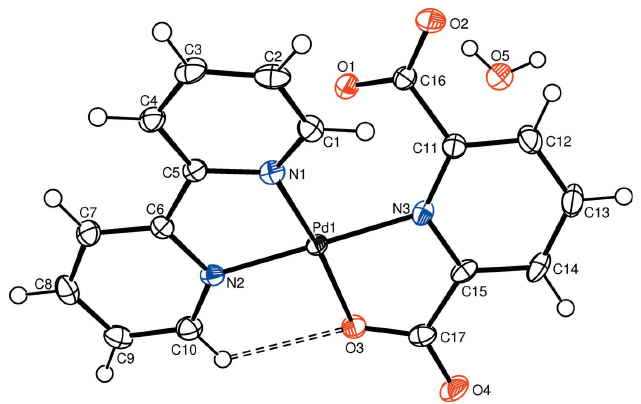
Figure 1 The molecular structure of the title compound showing the atom labelling and displacement ellipsoids drawn at the 50% probability level for non-H atoms. The intramolecular hydrogen bond is drawn as a double-dashed